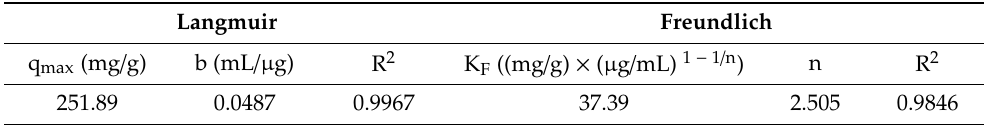
Table 2. Langmuir and Freundlich constants and correlation coe ffi